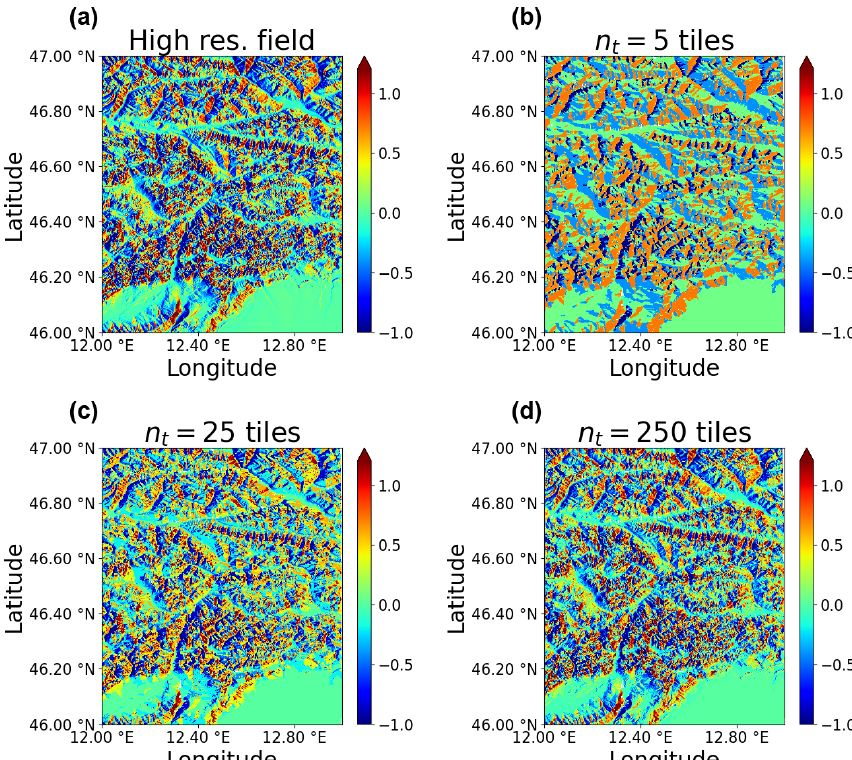
Figure 10. Normalized differences between 3D and PP direct fluxes for high-resolution predictions (a) and predictions for different numbers of tiles (5, 25, 250) in panels (b, c, d) . The sub-grid tile structure was obtained here by keeping constant the number of characteristic hillslopes ( k ), while varying the number of clusters in each hillslope ( p